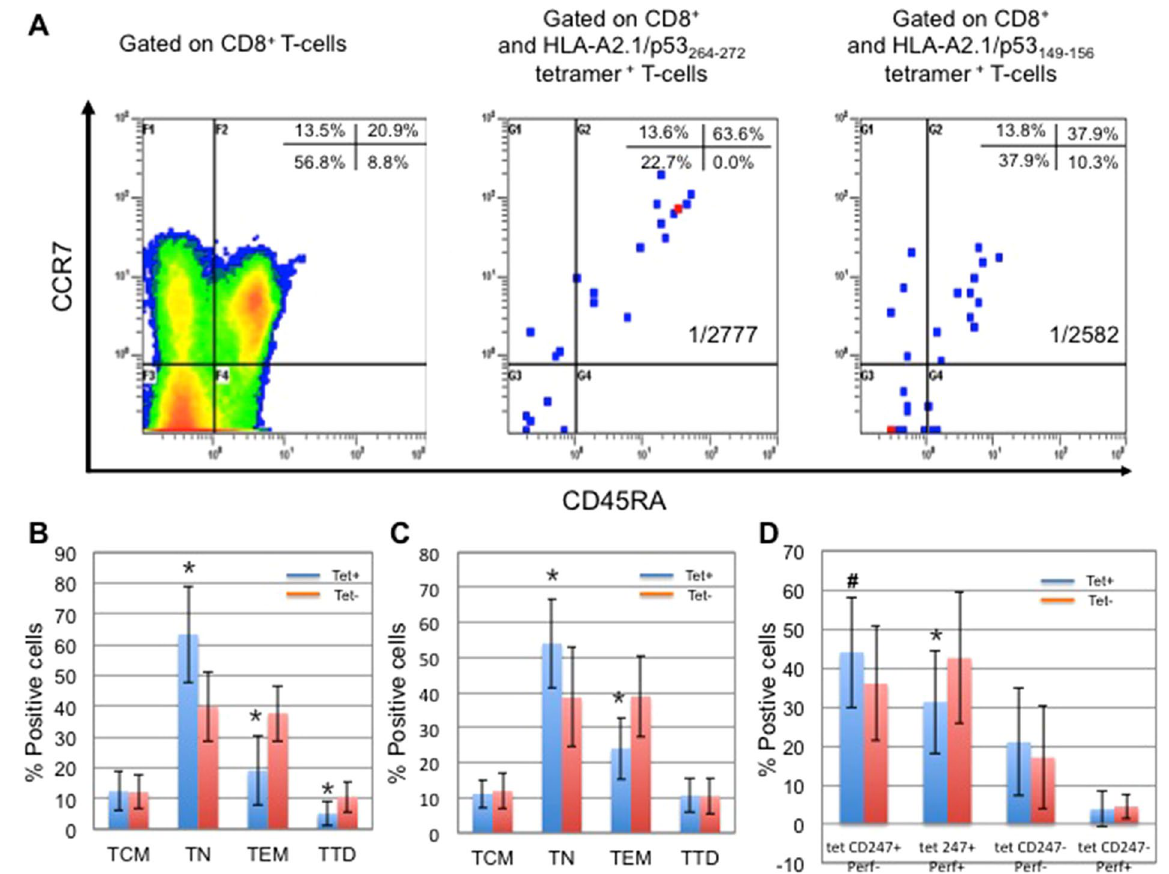
Figure 1. Differential Phenotypes of wt sequence p53 peptide-specific tet + CD8 + and tet − CD8 + T cells in the peripheral circulation of patients with head and neck cancer. Examples of dot plots for patient #1 are shown for ( A ) CD45RA and CCR7 expression by wt sequence p53 264–272 -specific or wt sequence p53 149-156 -specific CD8 + T cells, and differentiation phenotypes of ( B ) wt sequence p53 tet 264-272 − CD8 + T cells and wt p53 tet 264–272 + CD8 + T cells ( * p < 0.01), ( C ) wt sequence p53 tet 149–156 − CD8 + T cells and tet 149–156 + CD8 + T cells ( * p < 0.01), and ( D ) CD247/Perforin expression of wt p53 tet 264–272 − CD8 + T cells and wt p53 tet 264–272 + CD8 + T cells ( # p < 0.05; * p <